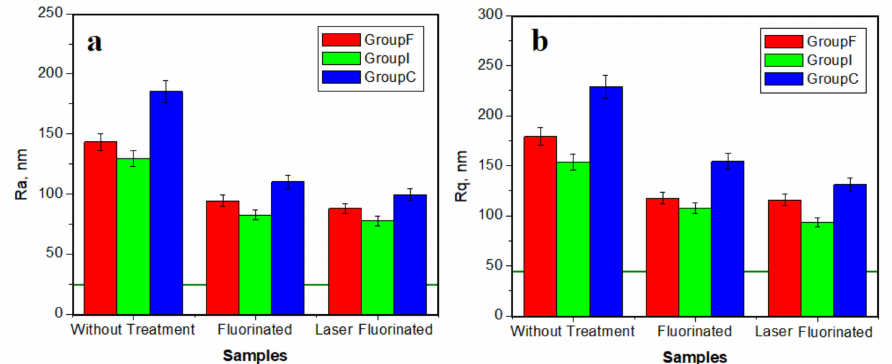
Figure 3. Average roughness variation with the applied treatment for the fine microstructure: ( a ) Ra and ( b ) Rq . The horizontal green line on the histograms represents the typical value for healthy